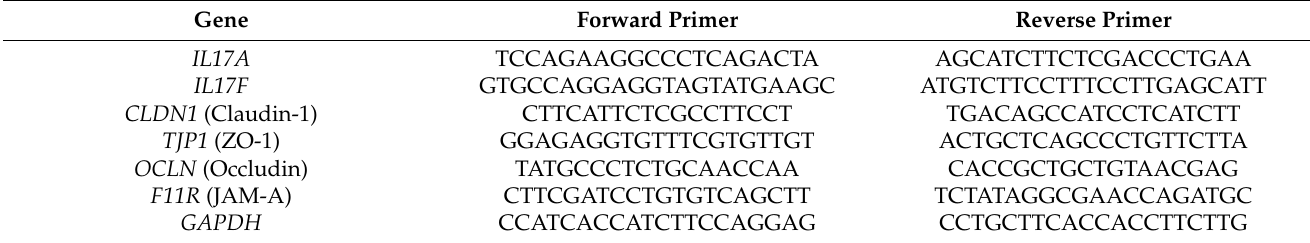
Table 1. Primers used for RT-PCR of IL-17 signaling pathway and tight junction-related